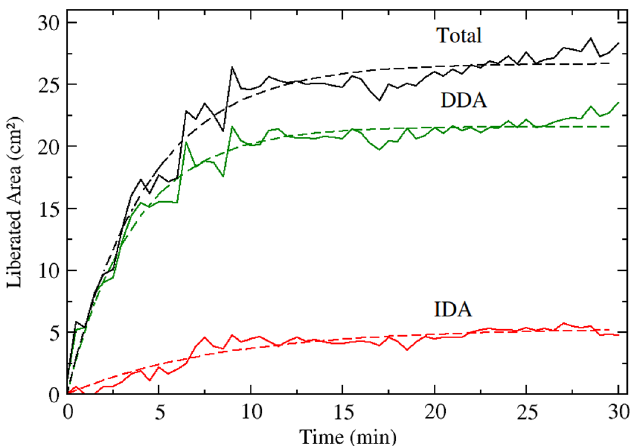
Fig 5. Liberated area due to aggregation of rods for DDA dimers (solid green line), IDA configurations (solid red line), and both mechanisms (solid black line) as a function of time from the start of the experiment. Dashed lines correspond to a function fitting as described in